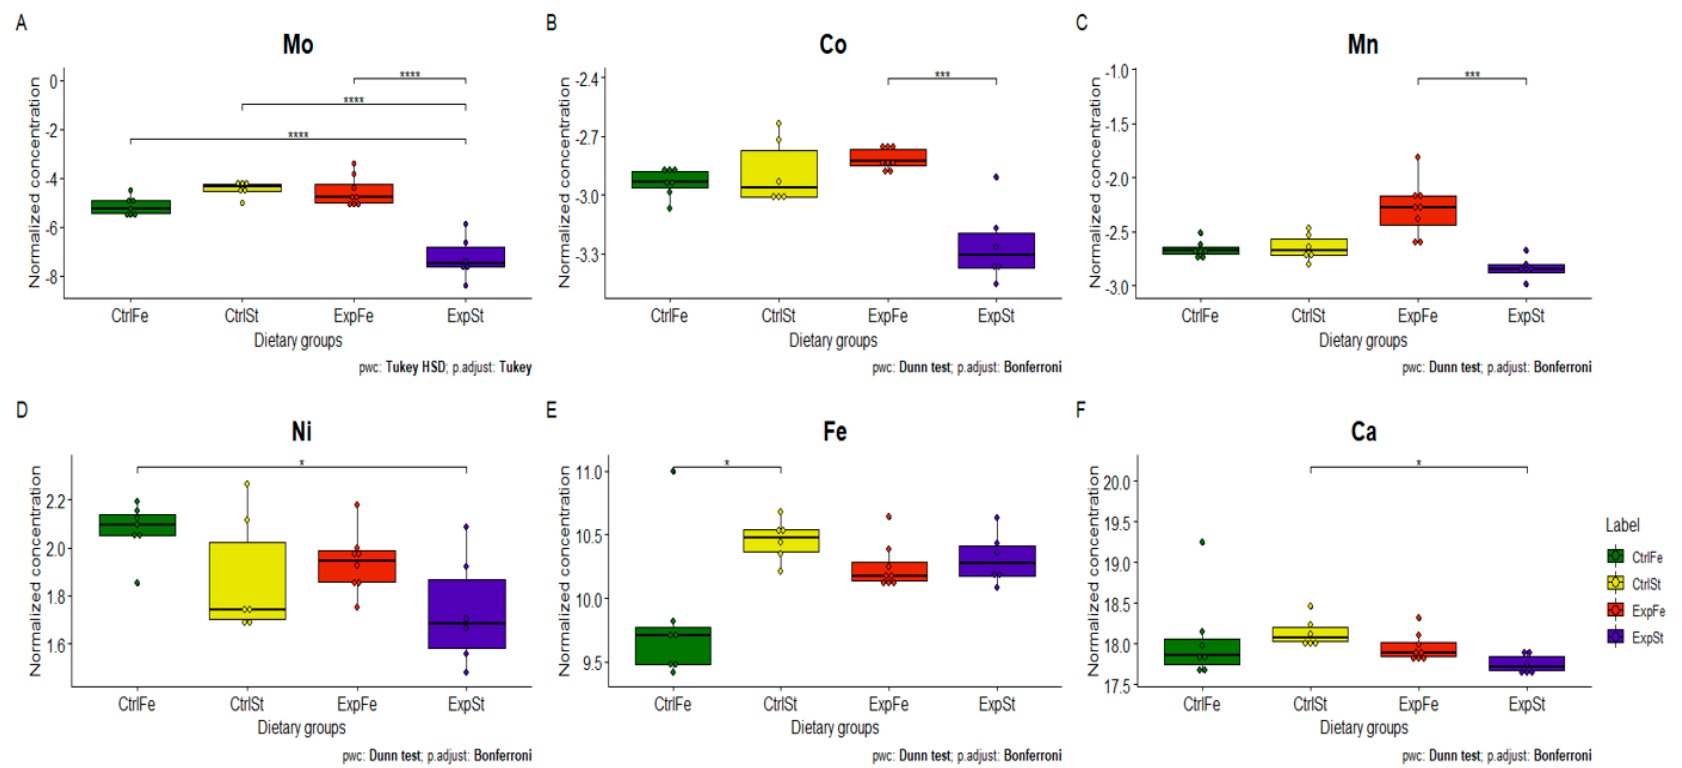
Figure 6. Analysis of concentrations of elements in four experimental groups: ExpSt—experimental standard diet with LNCaP (violet boxplot), CtrlSt—control standard diet without LNCaP (yellow boxplot); ExpFe—Fe supplementation diet with LNCaP (green boxplot); CtrlFe—Fe supplementation diet without LNCaP (red boxplot); p -value: <0.0001 ****, 0.0001–0.001 ***, 0.01–0.05 *.